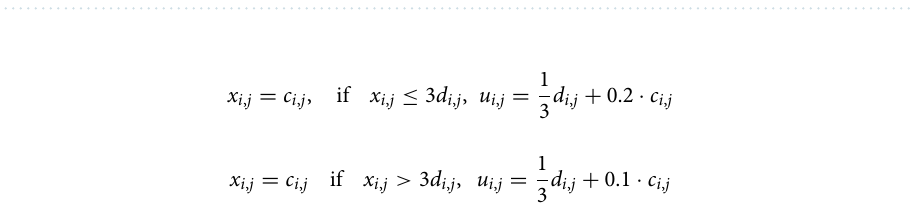
Table 1. Values of the descriptive statistics of HMs concentrations (mg . kg −1 ) in surface sediments of lakes in the N2